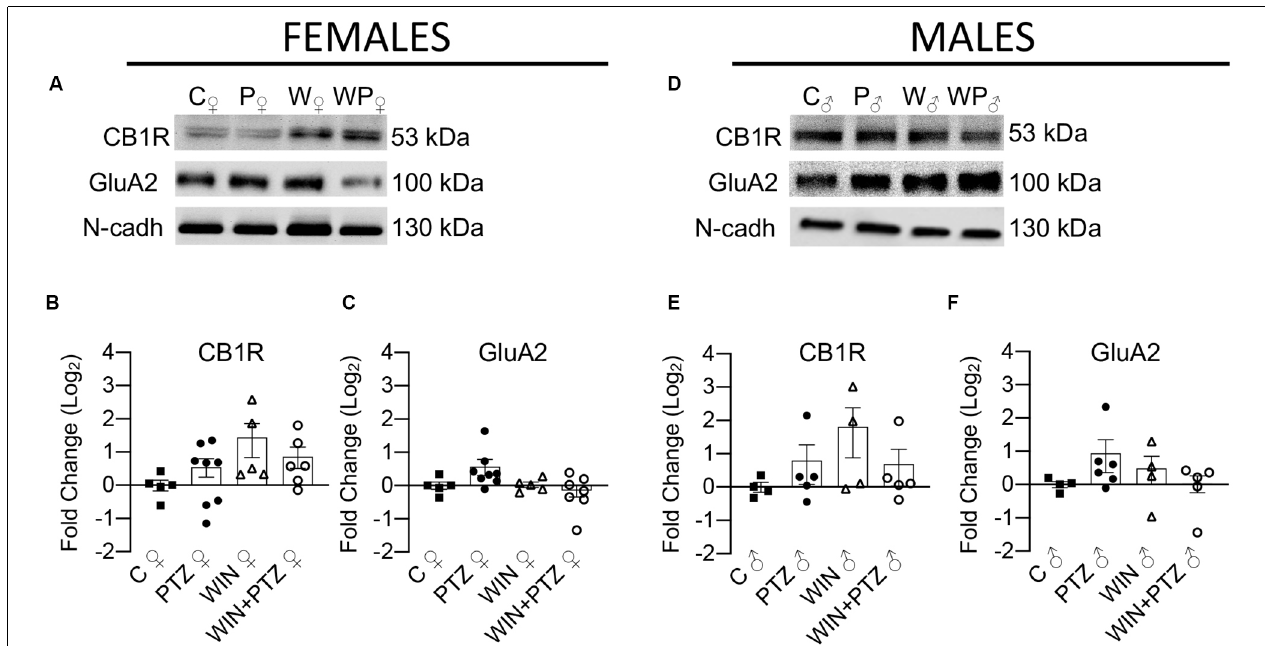
FIGURE 3 | Expression levels of membrane-bound CB1R and AMPAR subunit GluA2 in females and males. (A) Representative Western blots of membrane-bound CB1R and GluA2, in females and (D) males. (B) Quantification of membrane-bound CB1R levels in females (C, n = 5; PTZ, n = 8; WIN, n = 5; WIN + PTZ, n = 6). (C) Quantification of membrane-bound GluA2 levels in females (C, n = 5; PTZ, n = 8; WIN, n = 5; WIN + PTZ, n = 7). (E) Quantification of membrane-bound CB1R levels in males (C, n = 4; PTZ, n = 5; WIN, n = 4; WIN + PTZ, n = 5). (F) Quantification of membrane-bound GluA2 levels in males (C, n = 4; PTZ, n = 6; WIN, n = 4; WIN + PTZ, n = 5). N-cadherin was used as protein loading control for all